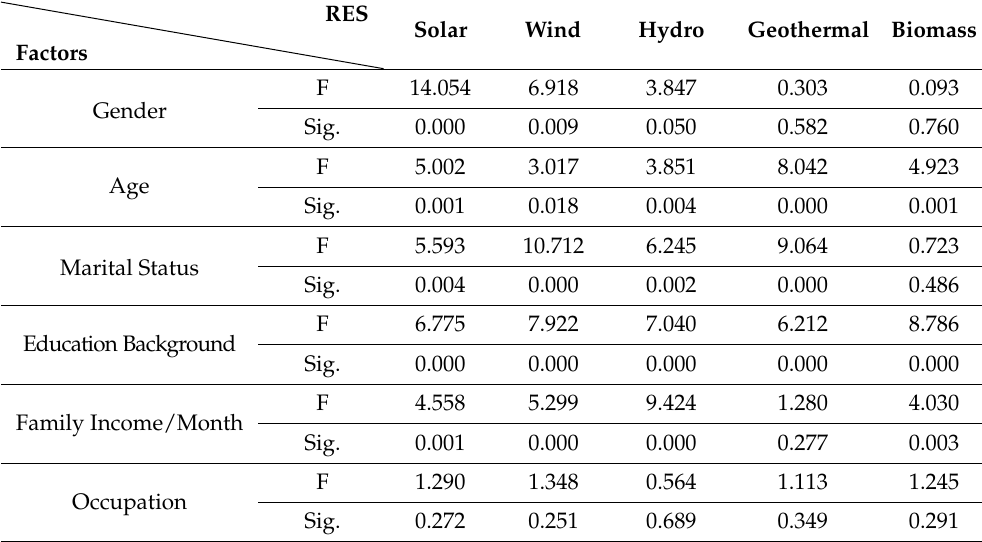
Table 5. ANOVA renewable energy sources with